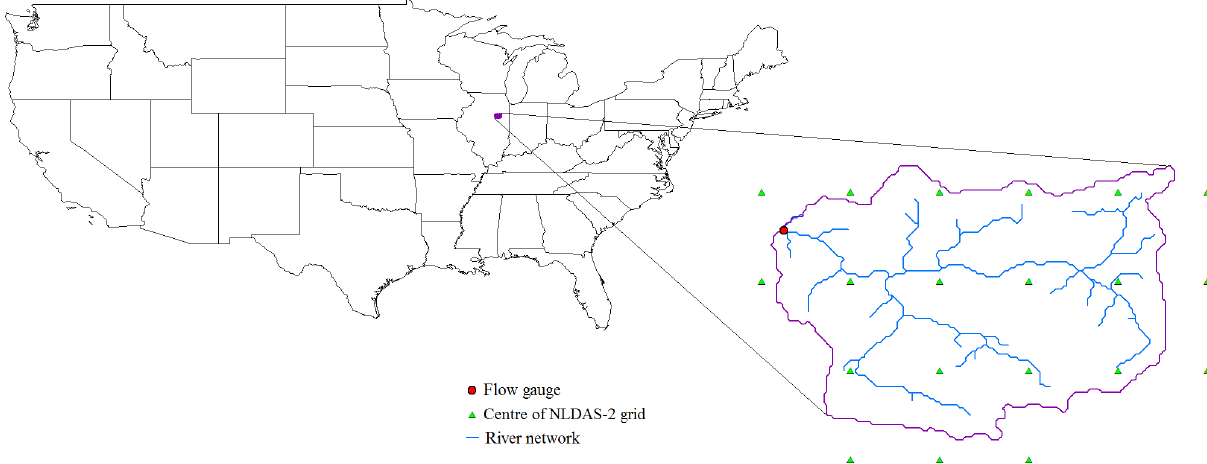
Figure 1. The location and river network of the Pontiac catchment in the U.S., with the flow gauge and NLDAS-2 central grid points (Zhuo et al.,